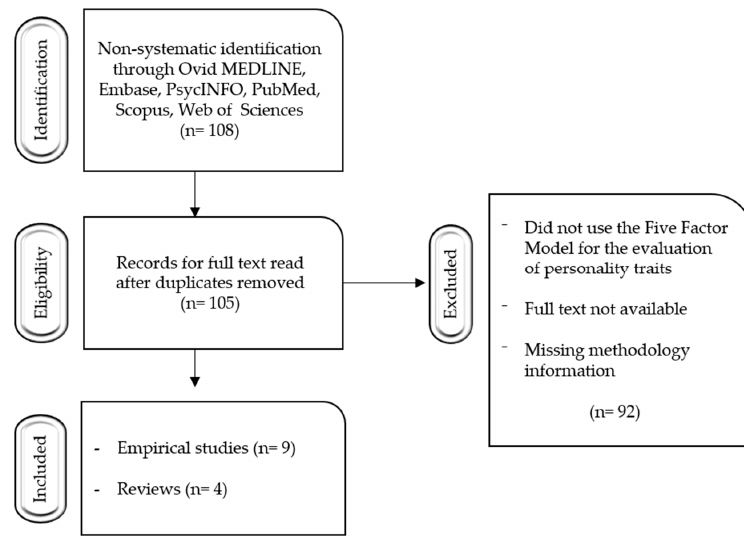
Figure 1. Selection of studies flowchart.